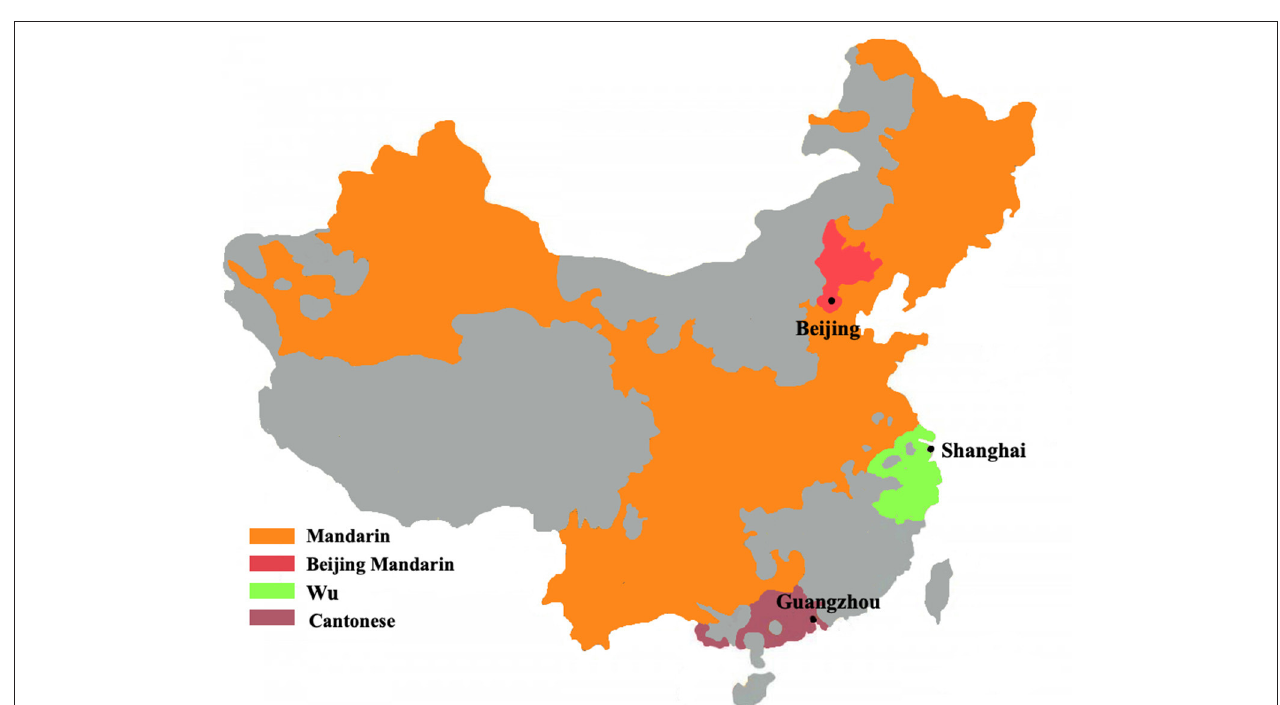
FIGURE A1 | Locations of Beijing Mandarin, Shanghai Wu, and Guangzhou